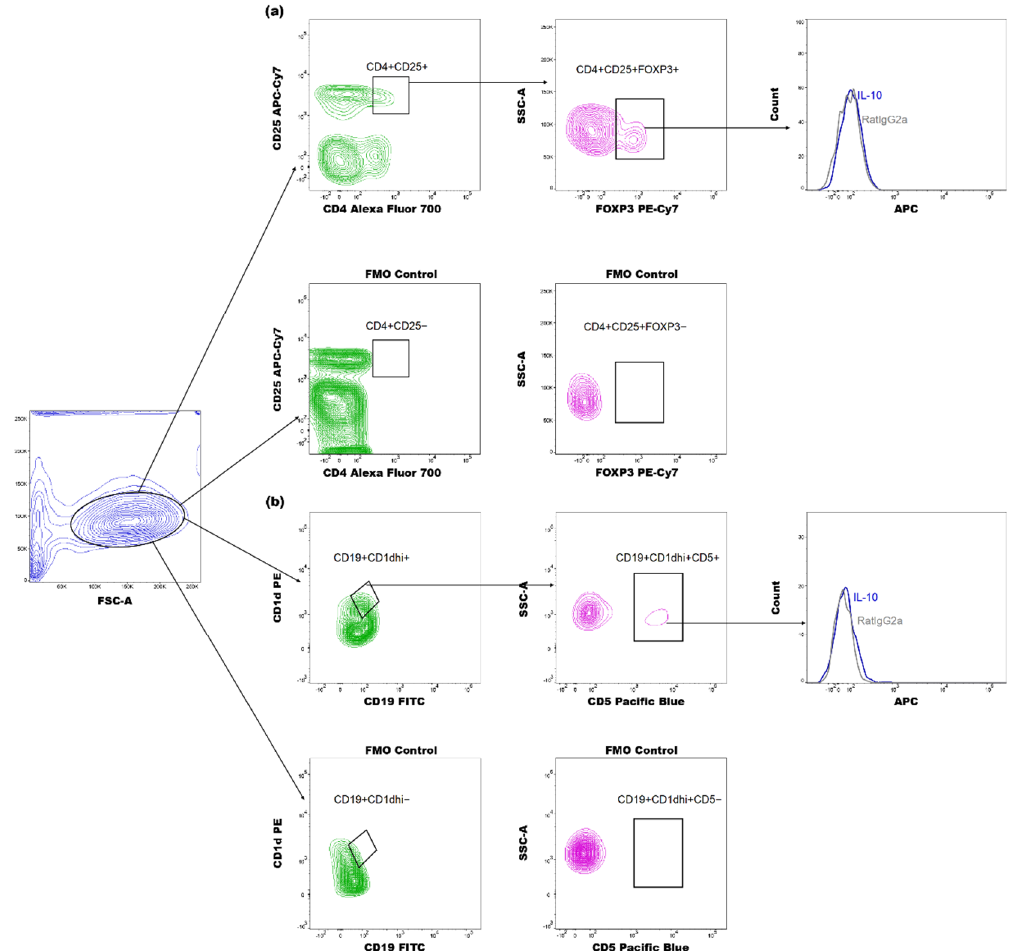
Figure 4. Representative dot plots for gating regulatory T (Tregs) and B lymphocytes (Bregs) and representative histograms of the expression of IL-10 (blue histograms) overlayed with those in the respective isotype-matched controls (red histograms) derived from the spleens of abortion-prone mice. ( a ) Gating strategy for CD4 + CD25 + FOXP3 + lymphocytes and IL-10 expression in these cells. ( b ) CD19 + CD1d high+ CD5 + lymphocytes and expression of IL-10 in these cells.